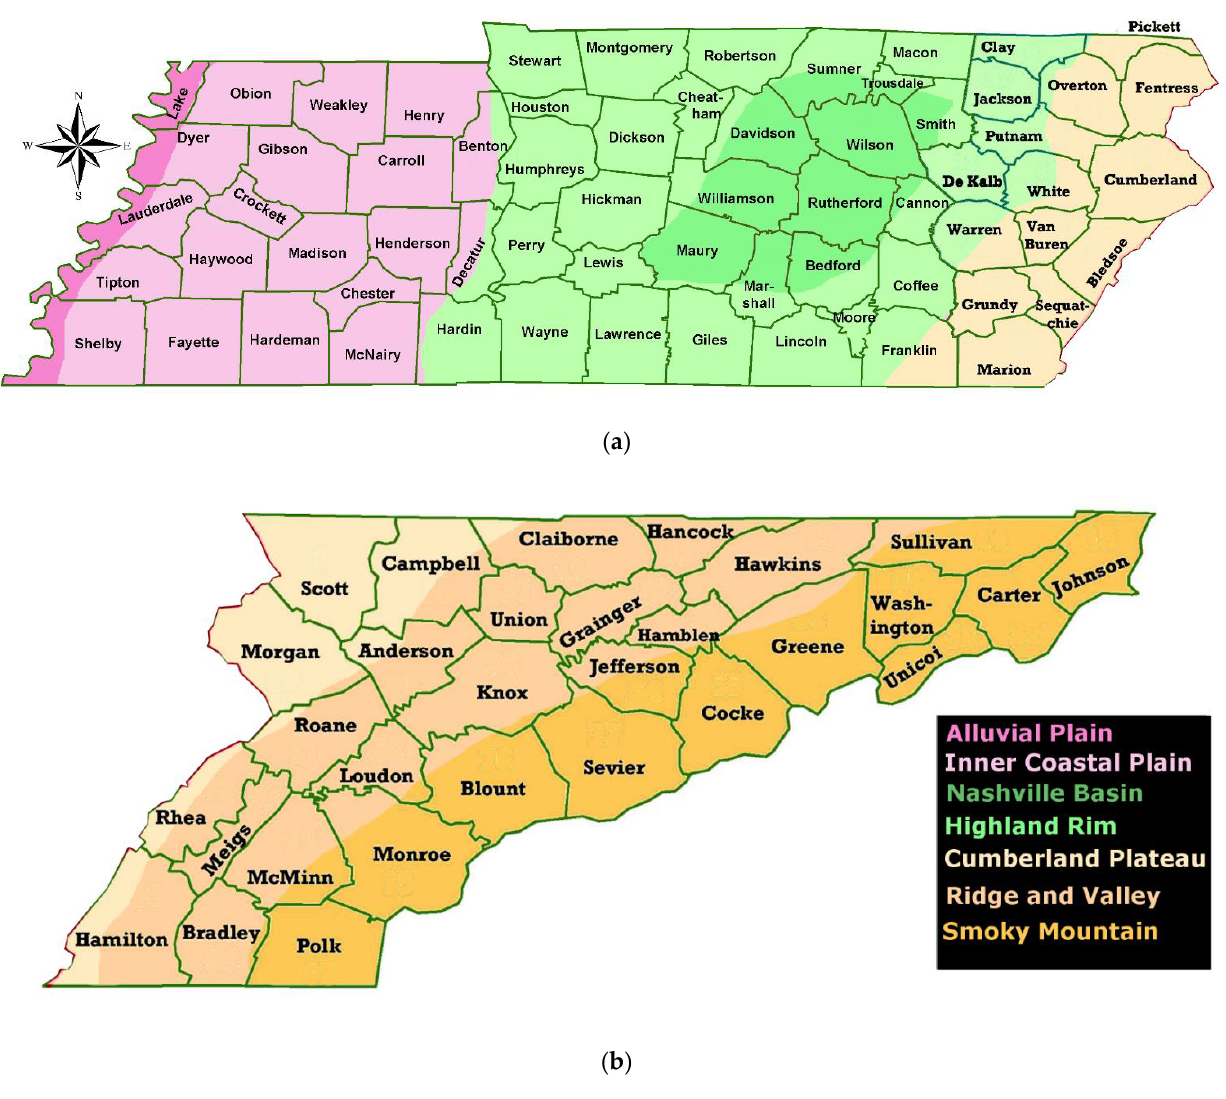
Figure 1. The 95 counties in the state of Tennessee and their geological regions by ( a ) Central Time Zone Regions (CST UTC-6:00, CDT UTC-5:00) and ( b ) Eastern Time Zone Regions (CST UTC-5:00, CDT UTC-4:00). [13].